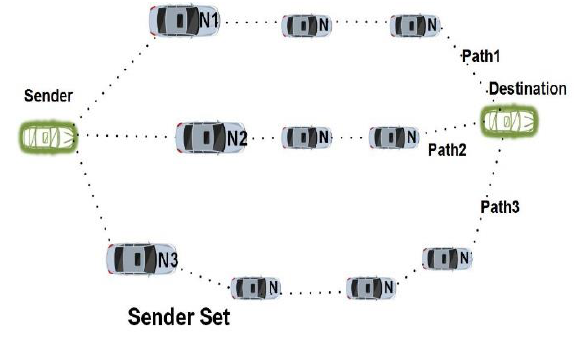
Figure 6. Rebroadcasting using opportunistic